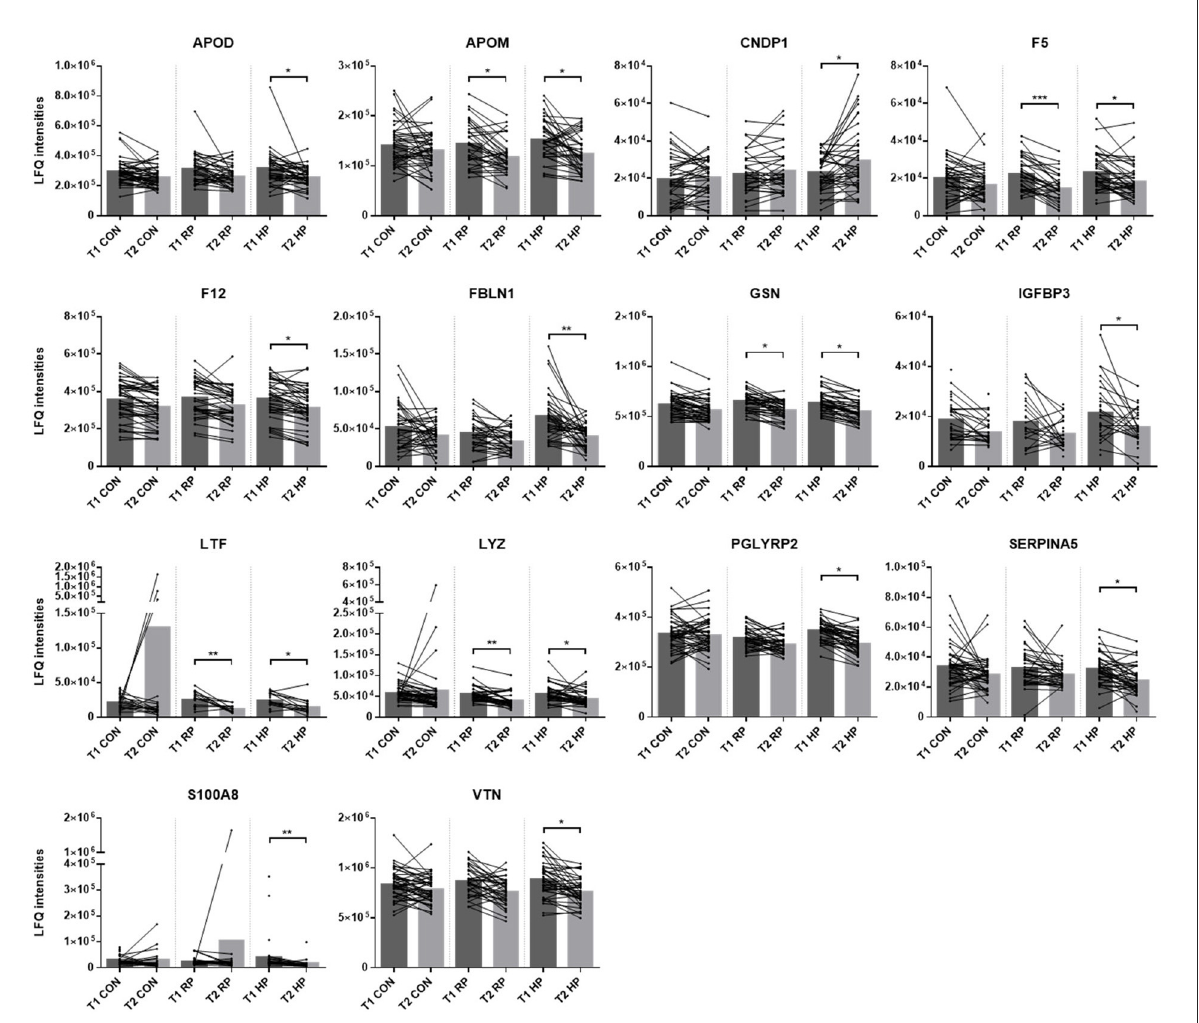
FIGURE6 Proteins specifically regulated upon high protein dietary intervention. Histograms display label-free quantification values (LFQ intensities) of proteins, significantly regulated upon dietary intervention in the high protein group. Significant changes between T1 and T2 within the control group (CON), the recommended protein group (RP) as well as the high protein group (HP) are marked with asterisks. * q -value ≤ 0.05, ** q -value ≤ 0.005 and *** q -value ≤ 0.001. Apolipoprotein D (APOD), apolipoprotein M (APOM), Beta-Ala-His dipeptidase (CNDP1), coagulation factor V (F5), coagulation factor XII (F12), fibulin 1 (FBLN1), gelsolin (GSN), insulin like growth factor binding protein 3 (IGFBP3), lactotransferrin (LTF), lysozyme C (LYZ), N-acetylmuramoyl-L-alanine amidase (PGLYRP2), plasma serine protease inhibitor 5 (SERPINA5), protein S100-A8 (S100A8), vitronectin